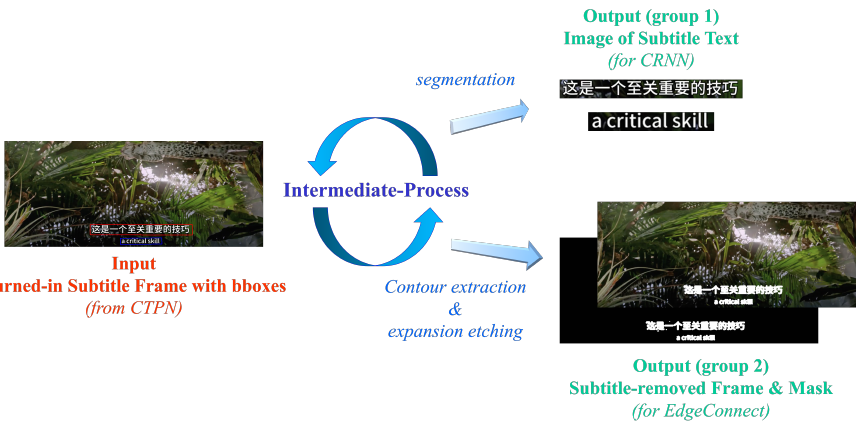
Figure 4. The burned-in subtitle frame with bboxes to subtitle text images and the subtitle-removed frame and mask, via the